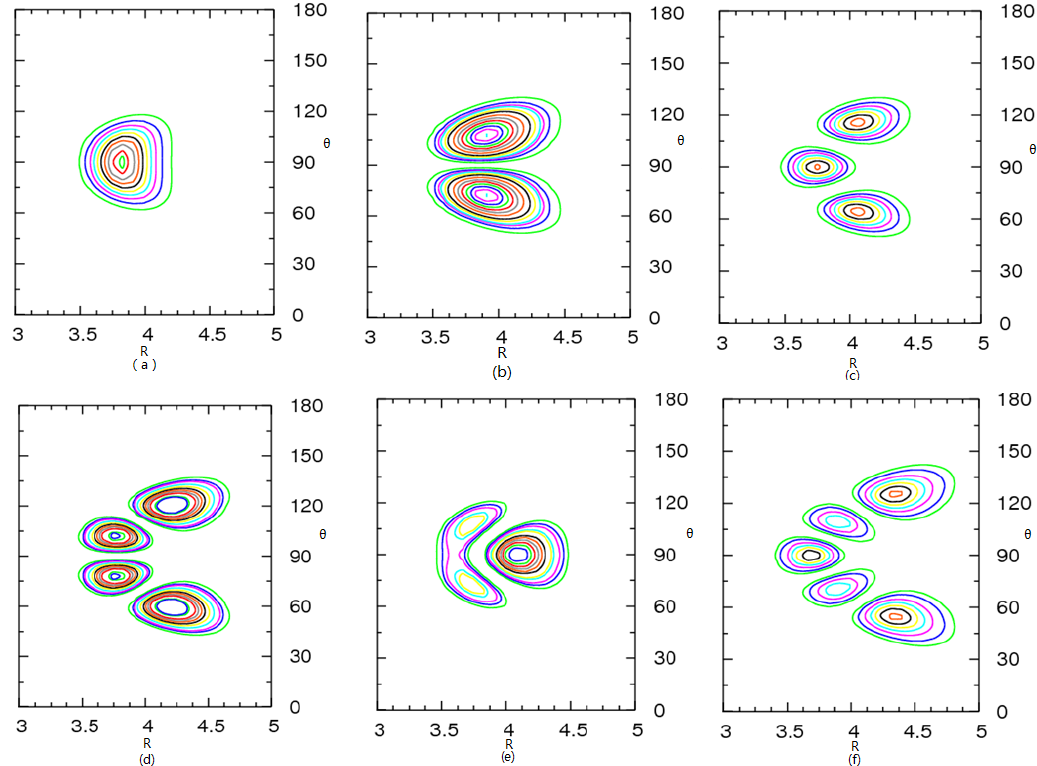
-Ar complex. The states are assigned by (nstretch, 3